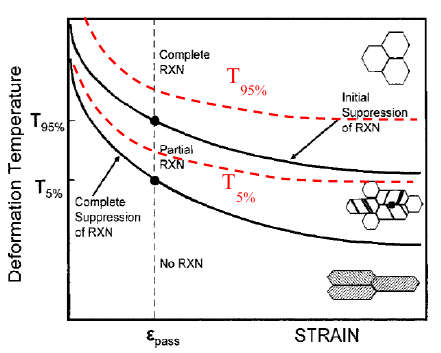
Figure 1. Schematic diagram of the resulting austenite microstructures from different deformation conditions, after reference [12]. T 5% and T 95% are temperatures for 5% and 95% recrystallization, respectively.